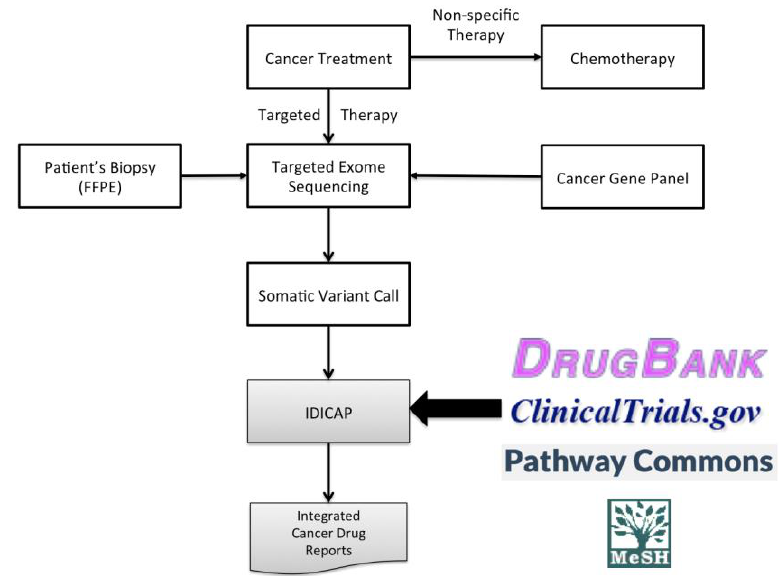
Figure 1. A roadmap of cancer therapy: non-specific and targeted therapies. IDICAP (Integrated Drug Intervention for CAncer Panel) plays the role in integrating drug and clinical trial information that treat the unique mutation profile of patients. FFPE: formalin-fixed, paraffin-embedded.